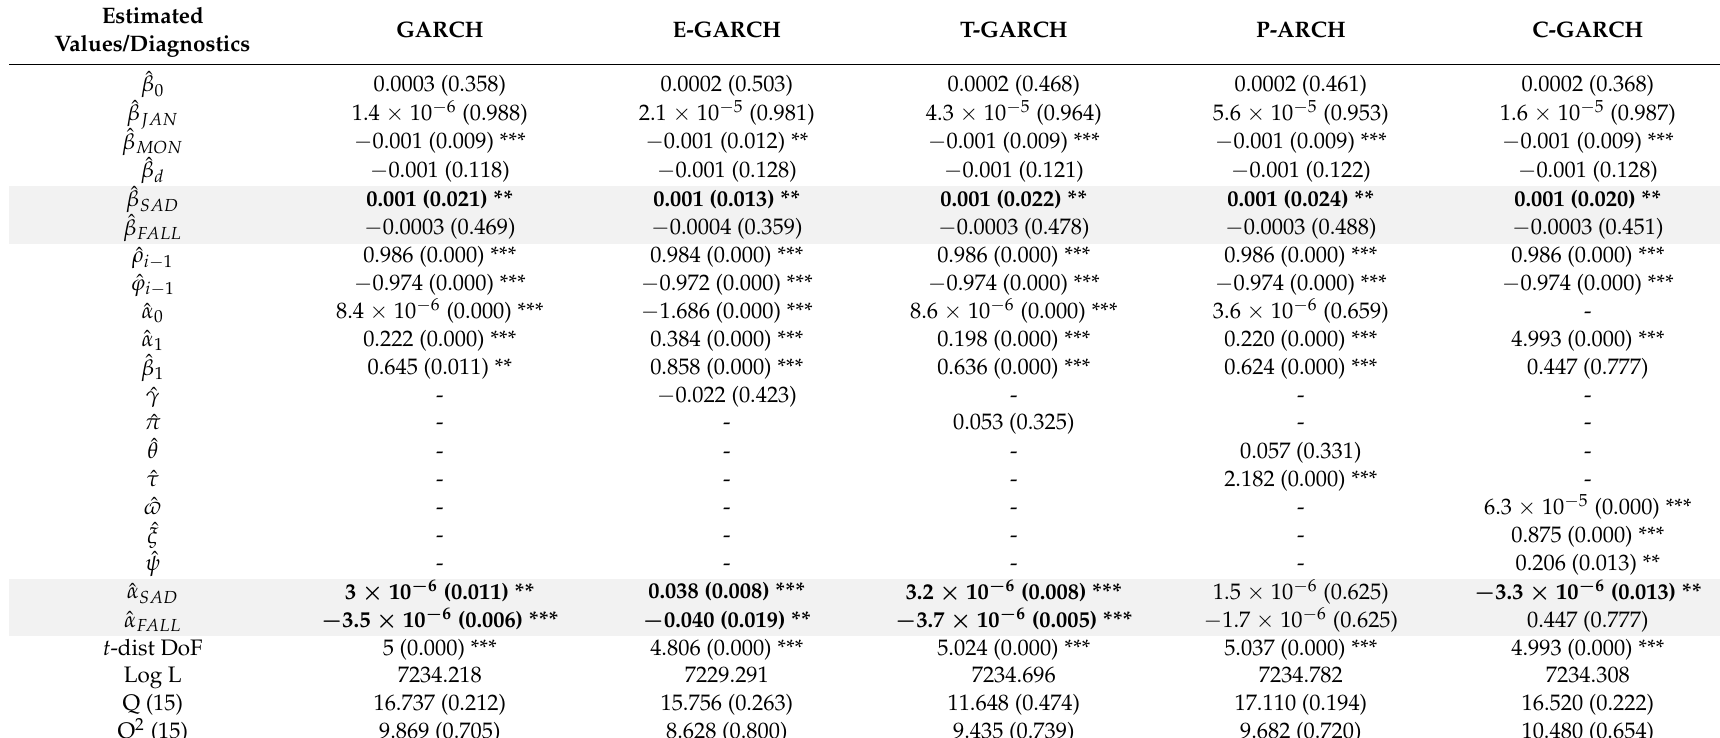
Table A9. Different GARCH specifications for